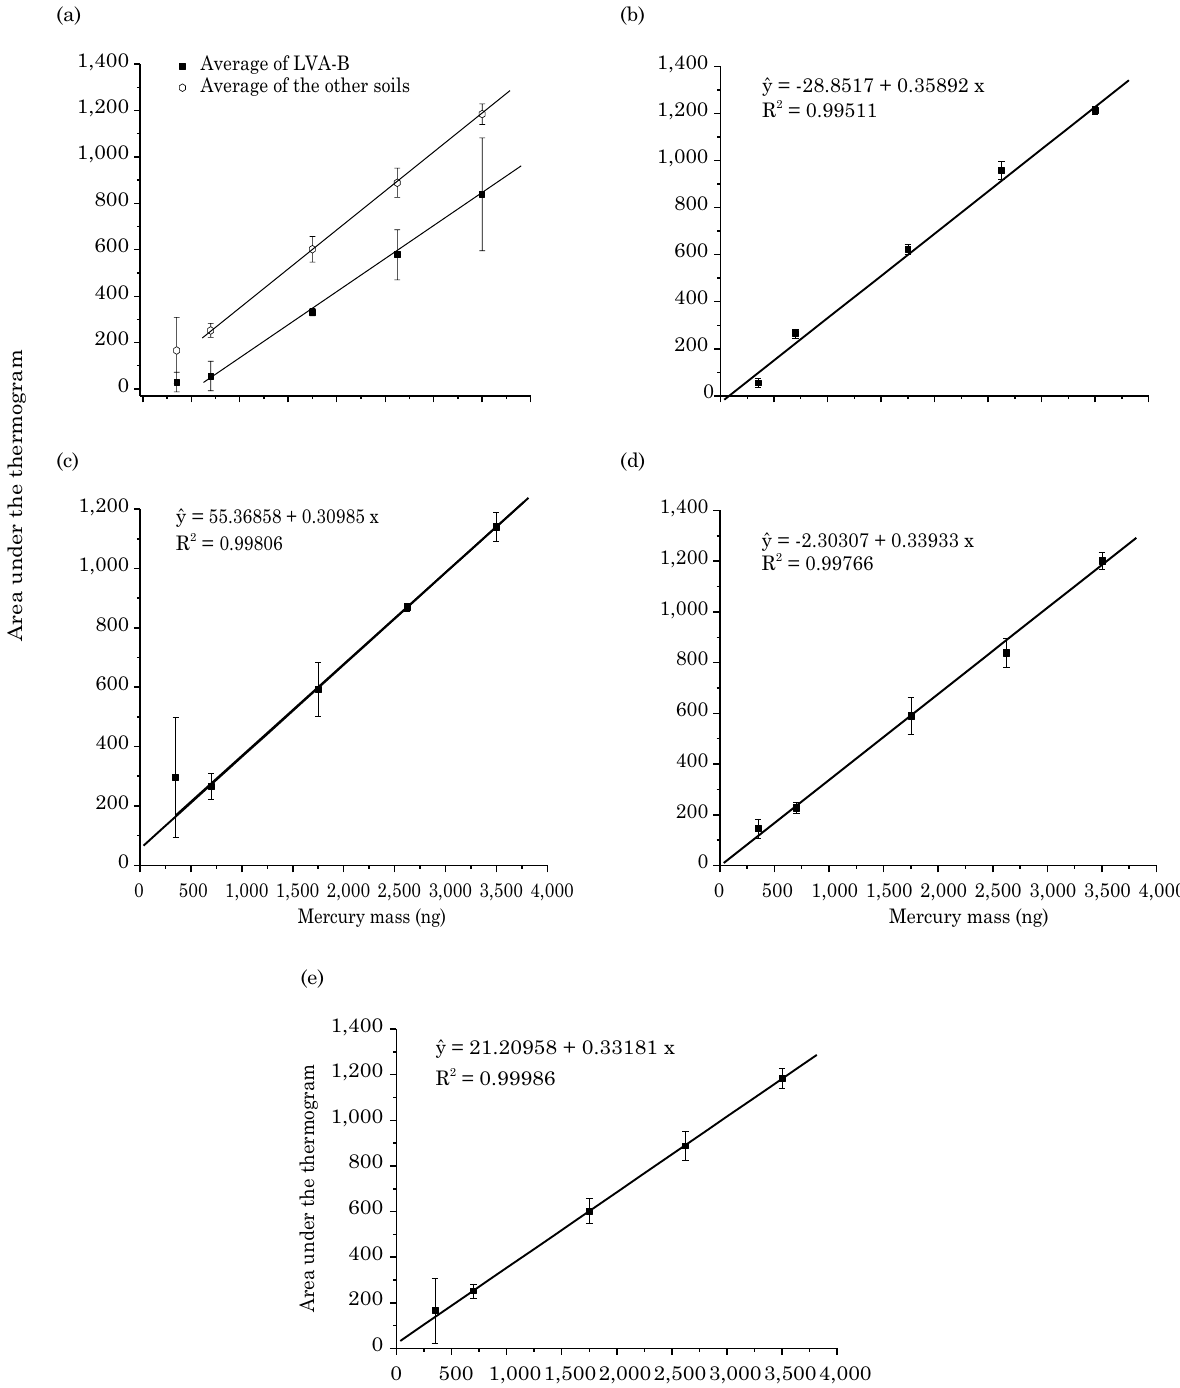
figure 3. Mercury calibration curves by thermal desorption associated with atomic absorption spectrometry in different matrices: (a) average of b horizon of humic Xanthic hapludox - lva-b and average of the other soils, (b) average of b horizon of oxic eutric haplustept - cXbe-b, (c) average of a horizon of Quartzipsamment - rQo-a, (d) average of c horizon of Quartzipsamment - rQo-c, and (e) average of cXbe-b, rQo-a, and rQo-c. the curve of each soil is constituted by the average of two replicates and the (e) curve is constituted by the average of six replicates (two from each